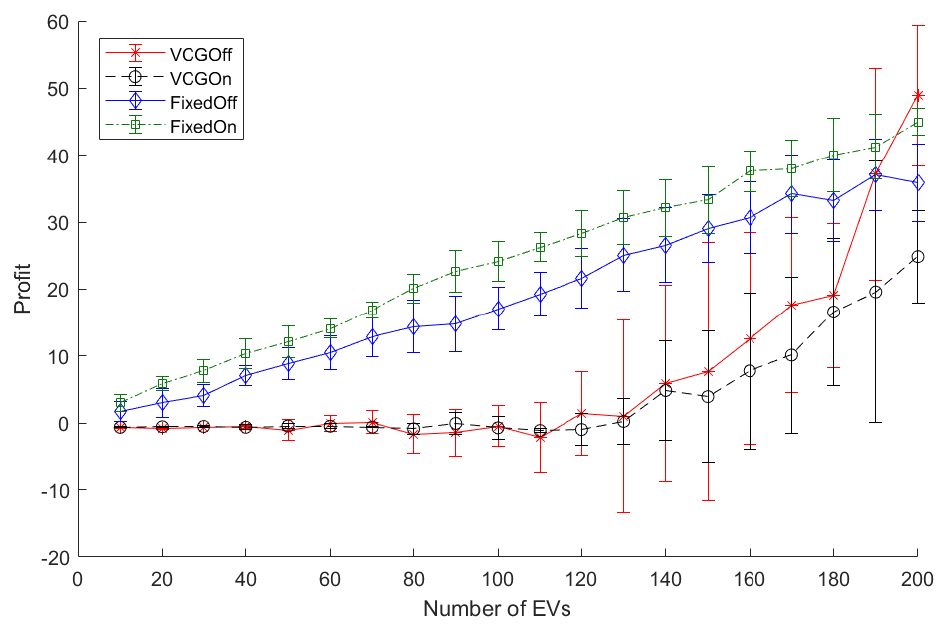
Figure 7. Total profit for the